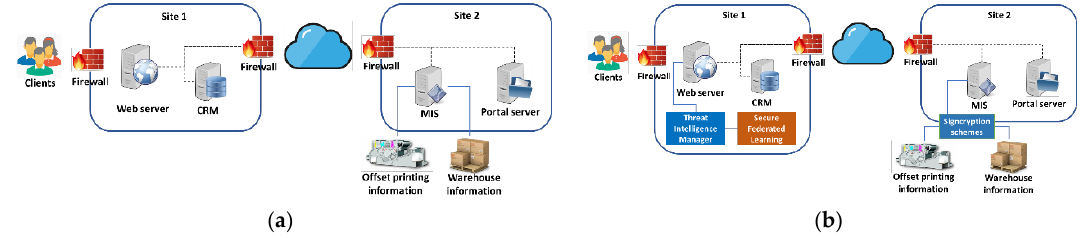
Figure 5. Current ( a ) and system-enhanced ( b ) web-to-print (W2P) solution.